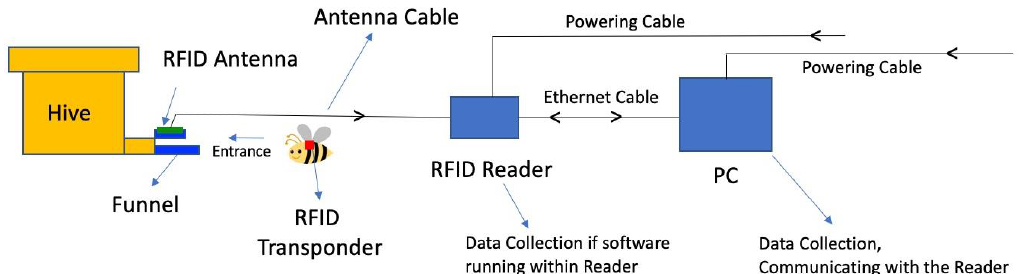
Figure 1. Description of the main operation phases and components of an RFID unit adjusted to accommodate honey bee research. The main items are a power source, RFID reader, portable computer, and RFID antenna. Modification of the honey bee hive entrance is required (funnel) to accommodate the antenna.